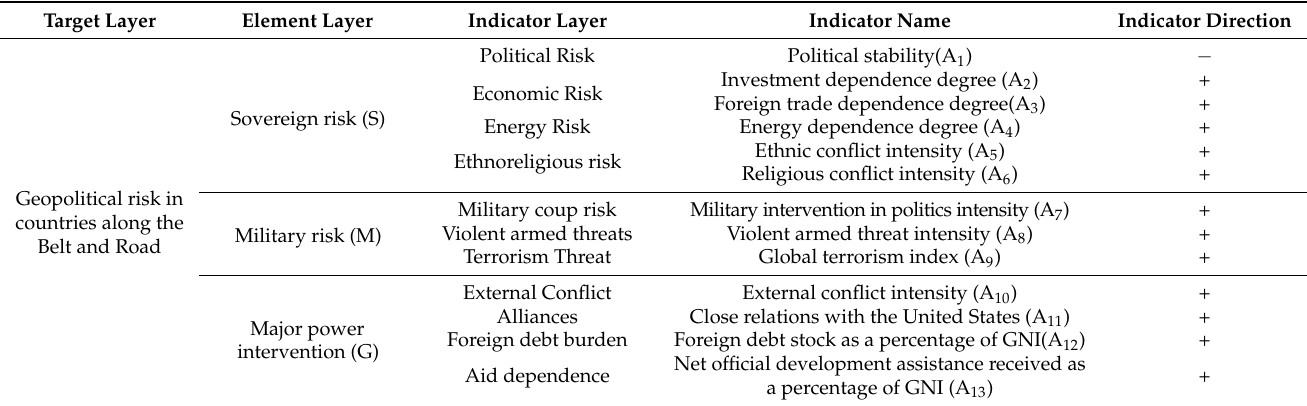
Table 1. Geopolitical risk indicator system of countries along the Belt and